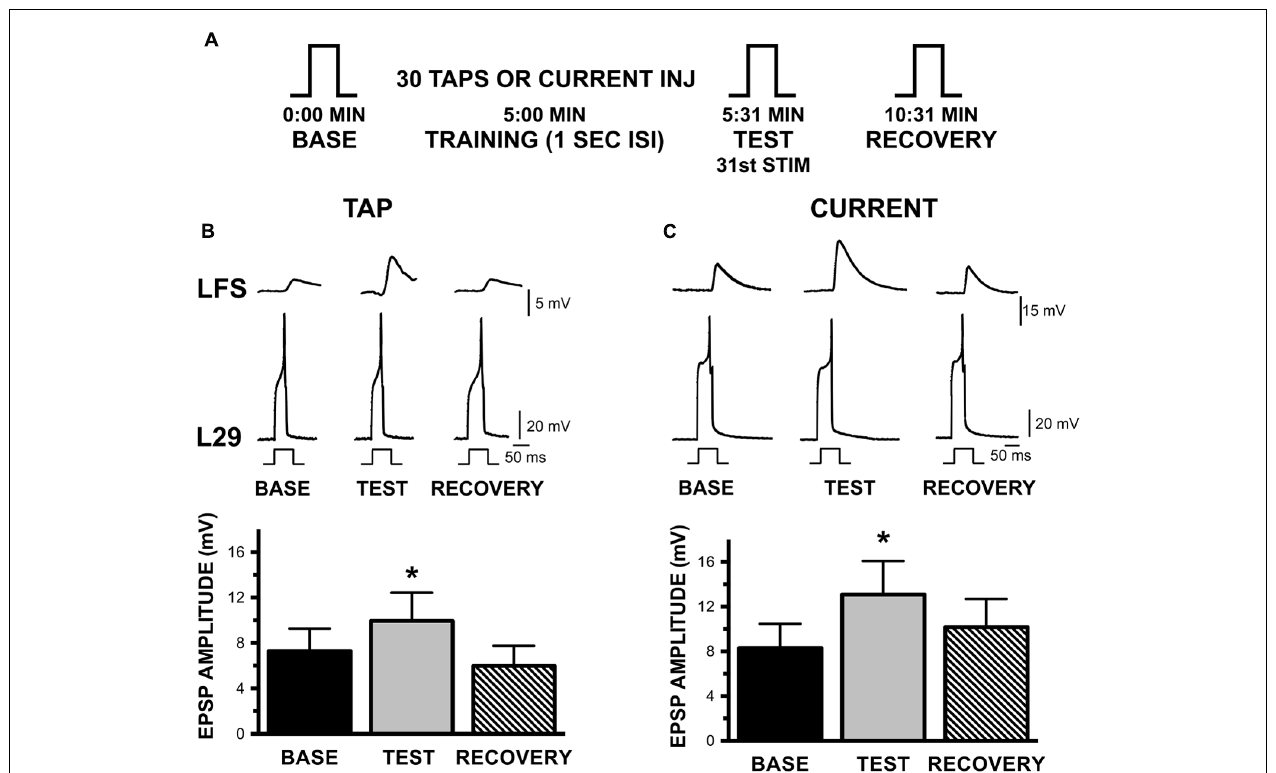
top traces illustrate representative physiological measures. All responses are measured by injecting brief depolarizing pulses into the L29s. LFS MNs were hyperpolarized ≈− 40 mV below rest, which eliminate the slow potential typically observed at this synapse. Data below the traces represent the average EPSP amplitude across nine experiments.TEST responses were significantly different from baseline. (C) Measures of the EPSP in the injected current training condition. Data below the traces represent the average EPSP amplitude across nine experiments. Again,TEST responses were significantly different from baseline. (* p < 0.05 from baseline using Bonferroni post